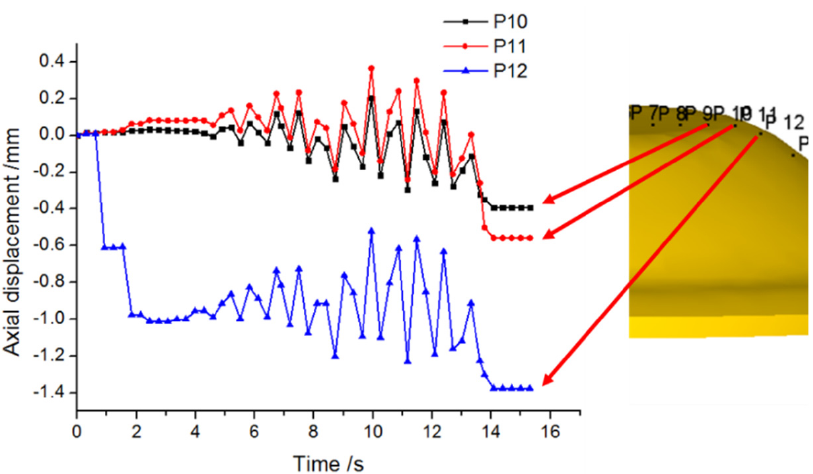
Figure 4. Axial displacement of sampling point in Zone 2.